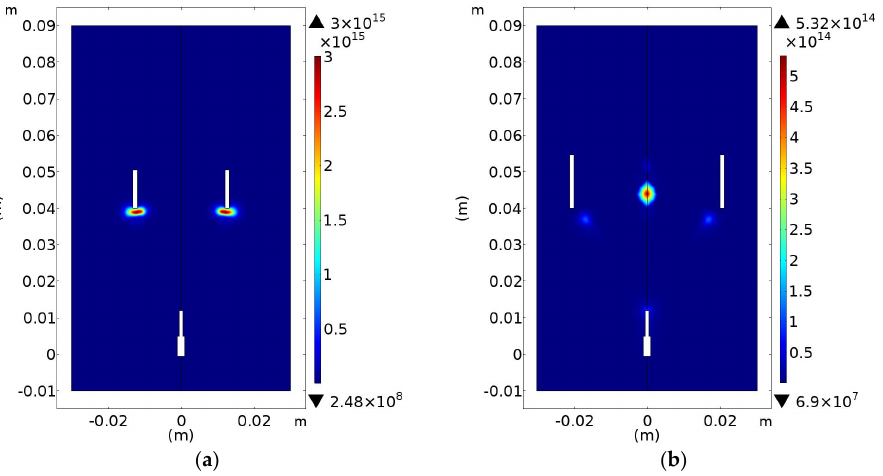
Figure 10. Spatial distributions of ion density (m − 3 ) for the optimal thruster output: ( a ) density of Ar + in the thruster with argon as propellant gas; ( b ) density of Xe + thruster with xenon as propellant gas.